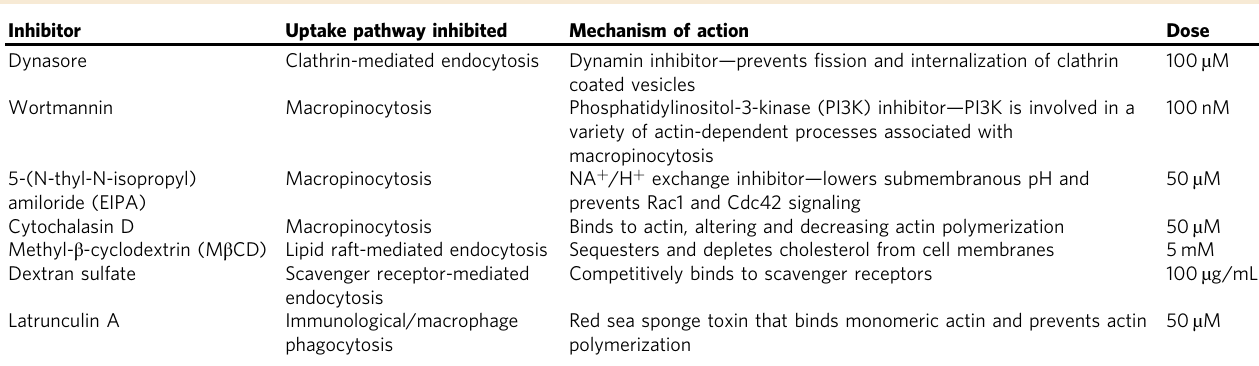
The uptake pathways affected by and underlying mechanism of action of the range of uptake inhibitors